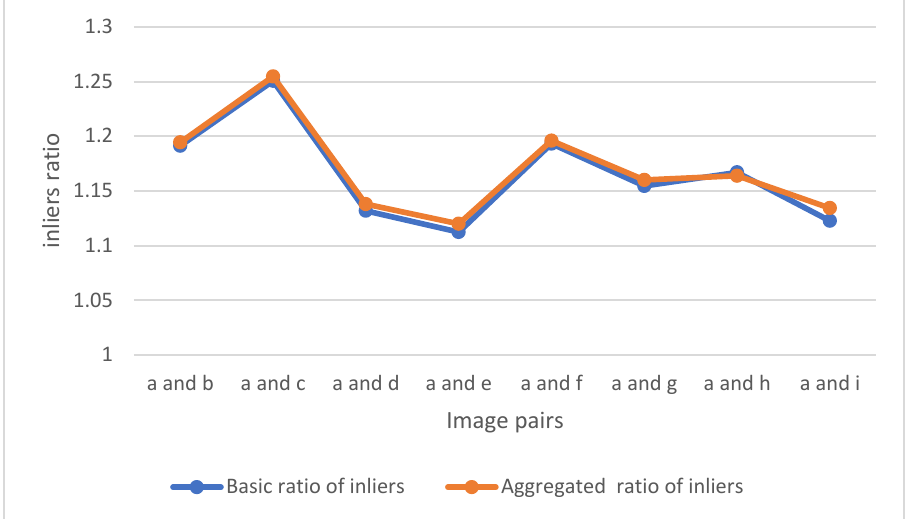
Figure 6. Ratio of inliers with respect to MSAC for the UAV dataset.